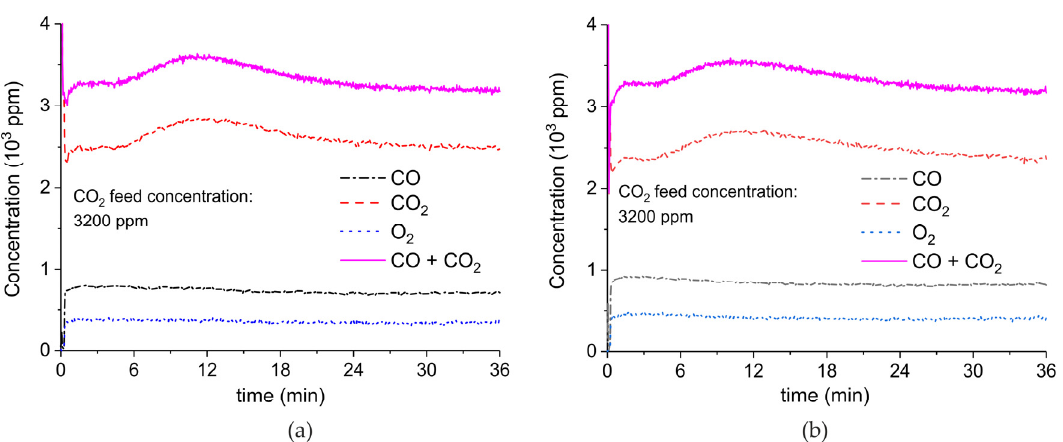
Figure A9. Concentration of the products of CaCO 3 decomposition (sample C) as function of time at 630 °C, flow rate of 90 mL/min. The fed CO 2 concentration is 3200 ppm and the plasma power is 1.4 W ( a ) and 1.5 W ( b ). The plasma is applied at the beginning of the reaction. The decomposition cycles are in order #16, #17.